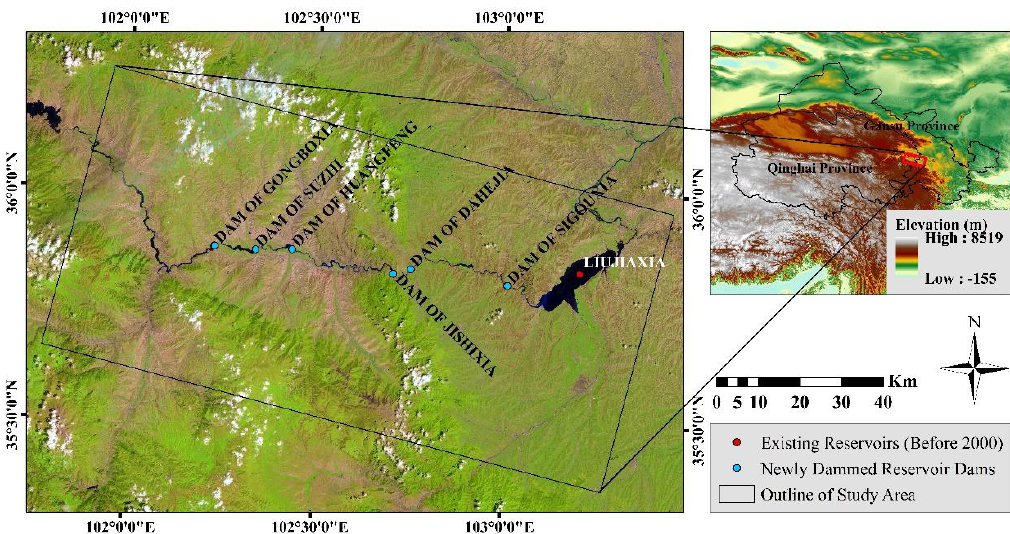
Figure 1. The study area is located in the upper reach of the Yellow River, with a lot of reservoirs built on it. The overview image shows the location of the study area and the terrains in and around the study area. The background was generated by mosaicking two adjacent Landsat-8 OLI RGB composite images. The locations of newly-built reservoirs/dams in the study area derived from Google Earth imagery are marked in this figure.